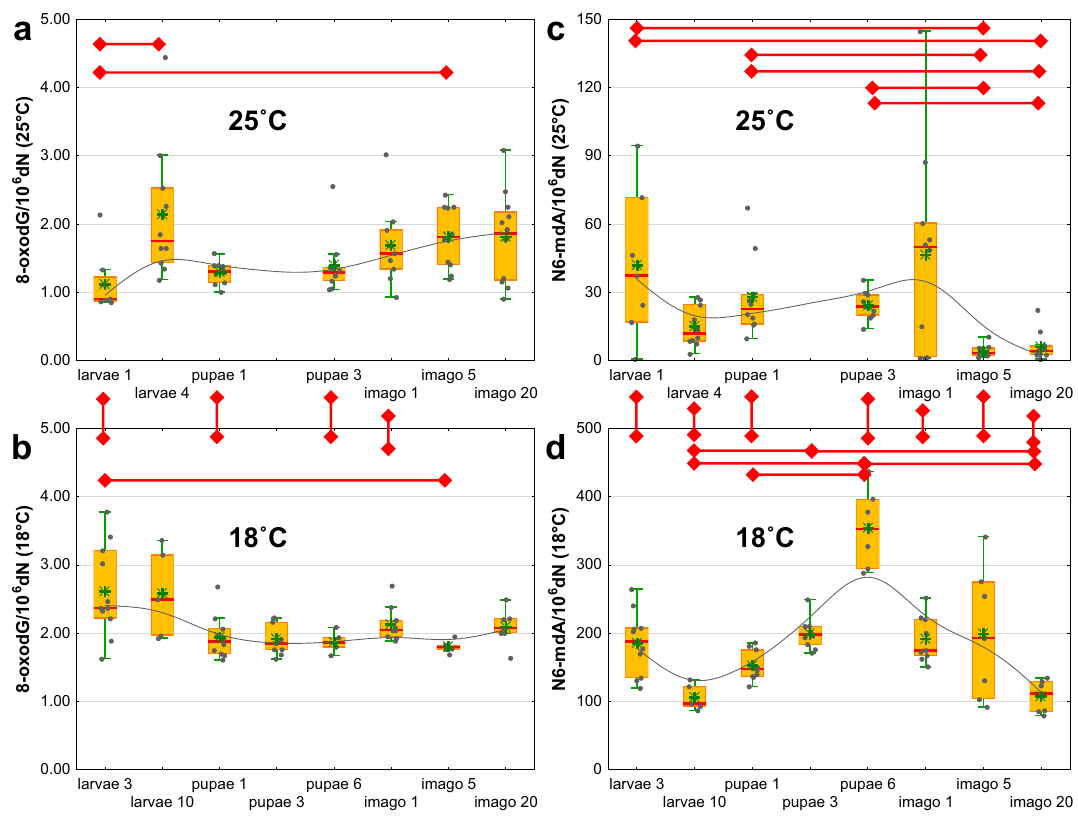
Figure 3. Changes in the levels of 8-oxo-7,8-dihydro-2 ′ -deoxyguanosine (8-oxodG) and N6-methyl-2 ′ - deoxyadenosine (N6-mdA) during the D. melanogaster life cycle ( a ) 8-oxo-7,8-dihydro-2 ′ -deoxyguanosine in insects bred in optimal temperature conditions (25 °C), ( b ) 8-oxo-7,8-dihydro-2 ′ -deoxyguanosine in insects bred at 18 °C, ( c ) N6-methyl-2 ′ -deoxyadenosine in insects bred in optimal temperature conditions (25 °C), ( d ) N6-methyl-2 ′ -deoxyadenosine in insects bred at 18 °C. The results are presented as the mean and median values, interquartile ranges, and nonoutlier ranges ( p <